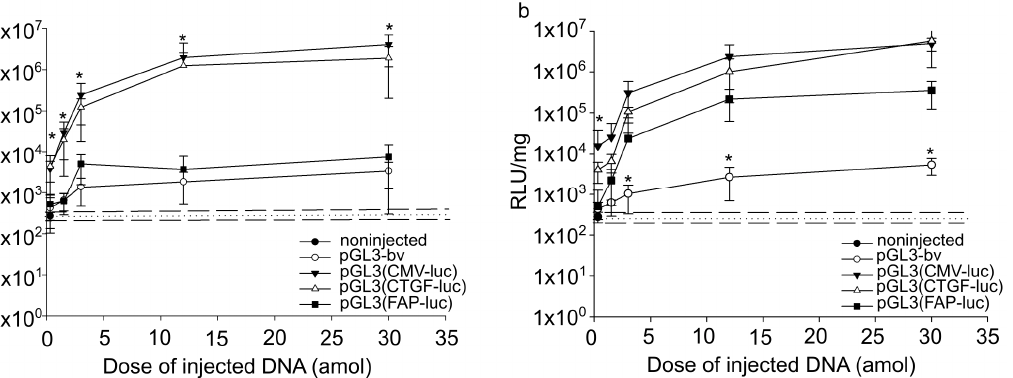
Figure 1. Luciferase activity in zebrafish embryos 24 h ( a ) and 96 h ( b ) after injection. Abscissa: quantities injected vectors pGL3(CMV-luc), pGL3(CTGF-luc), pGL3(FAP-luc), and pGL3-bv. Ordinate, relative luminescence units (RLU) normalized to 1 mg total protein in embryonic lysates, logarithmic scale. The dotted line indicates the average luminescence level in lysates of uninjected embryos, and the dashed lines indicate the size of error bars. ( a ) Significant differences in the luciferase activity after the injection of pGL3(CMV-luc) and pGL3(CTGF-luc) relative to vectors pGL3(FAP-luc) and pGL3-bv were observed over the whole DNA dose range ( p < 0.05). ( b ) Significant differences in the luciferase activity after the injection of pGL3(FAP-luc), pGL3(CMV-luc), and pGL3(CTGF-luc) relative to vector pGL3-bv were observed from 3 to 30 a tt omoles DNA dose range ( p < 0.05). The values were averaged for three independent experiments with three replicates for each point ( n = 27). Error bars indicate standard deviation (SD), * p < 0.5.